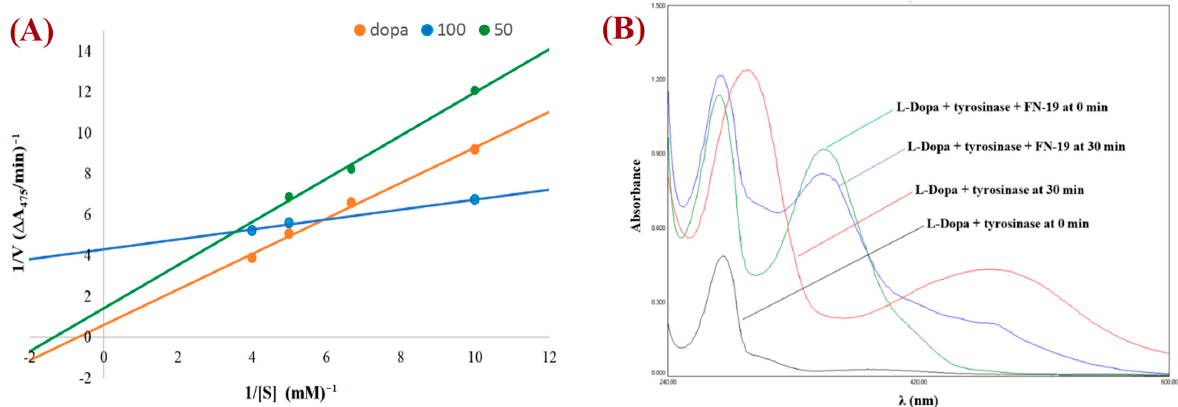
Figure 3. Lineweaver–Burk plot for FN-19 (at 100 mM (blue) and 50 mM (green)) obtained with the Michaelis–Menten equation ( A ) and UV-vis spectra for L-DOPA by tyrosinase in the presence and absence of FN-19 inhibitor ( B ). Table 2. Binding modes of coumarin analogs toward mushroom tyrosinase enzyme. Compound at 0.1